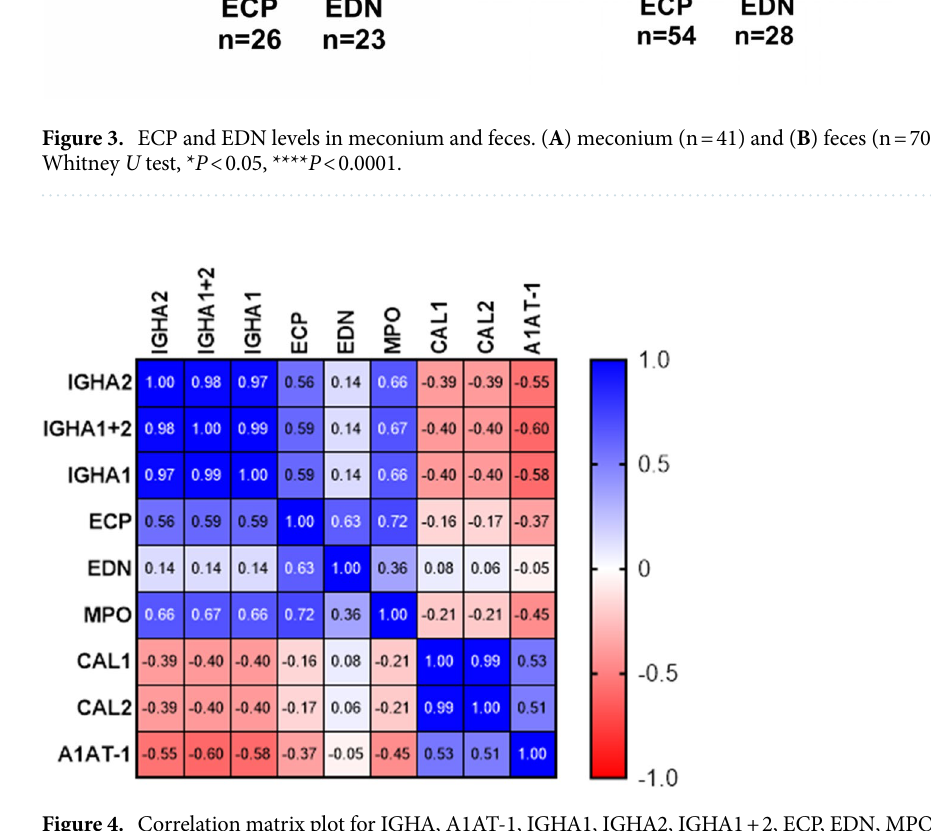
Figure 4. Correlation matrix plot for IGHA, A1AT-1, IGHA1, IGHA2, IGHA1 + 2, ECP, EDN, MPO, CAL1, and CAL2 levels in neonatal stool samples (n =